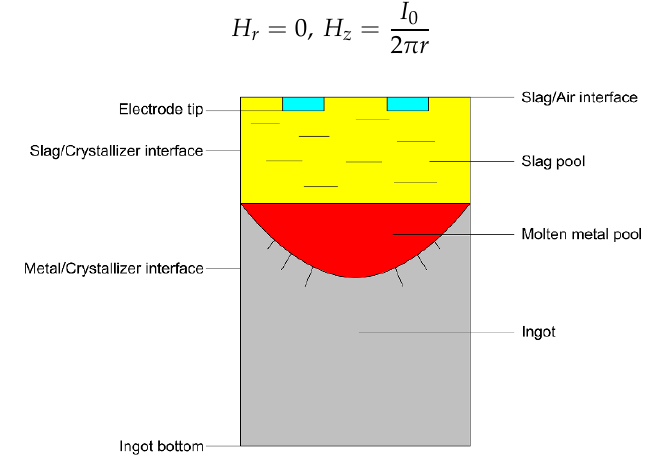
Figure 3. Schematic diagram of boundary conditions.